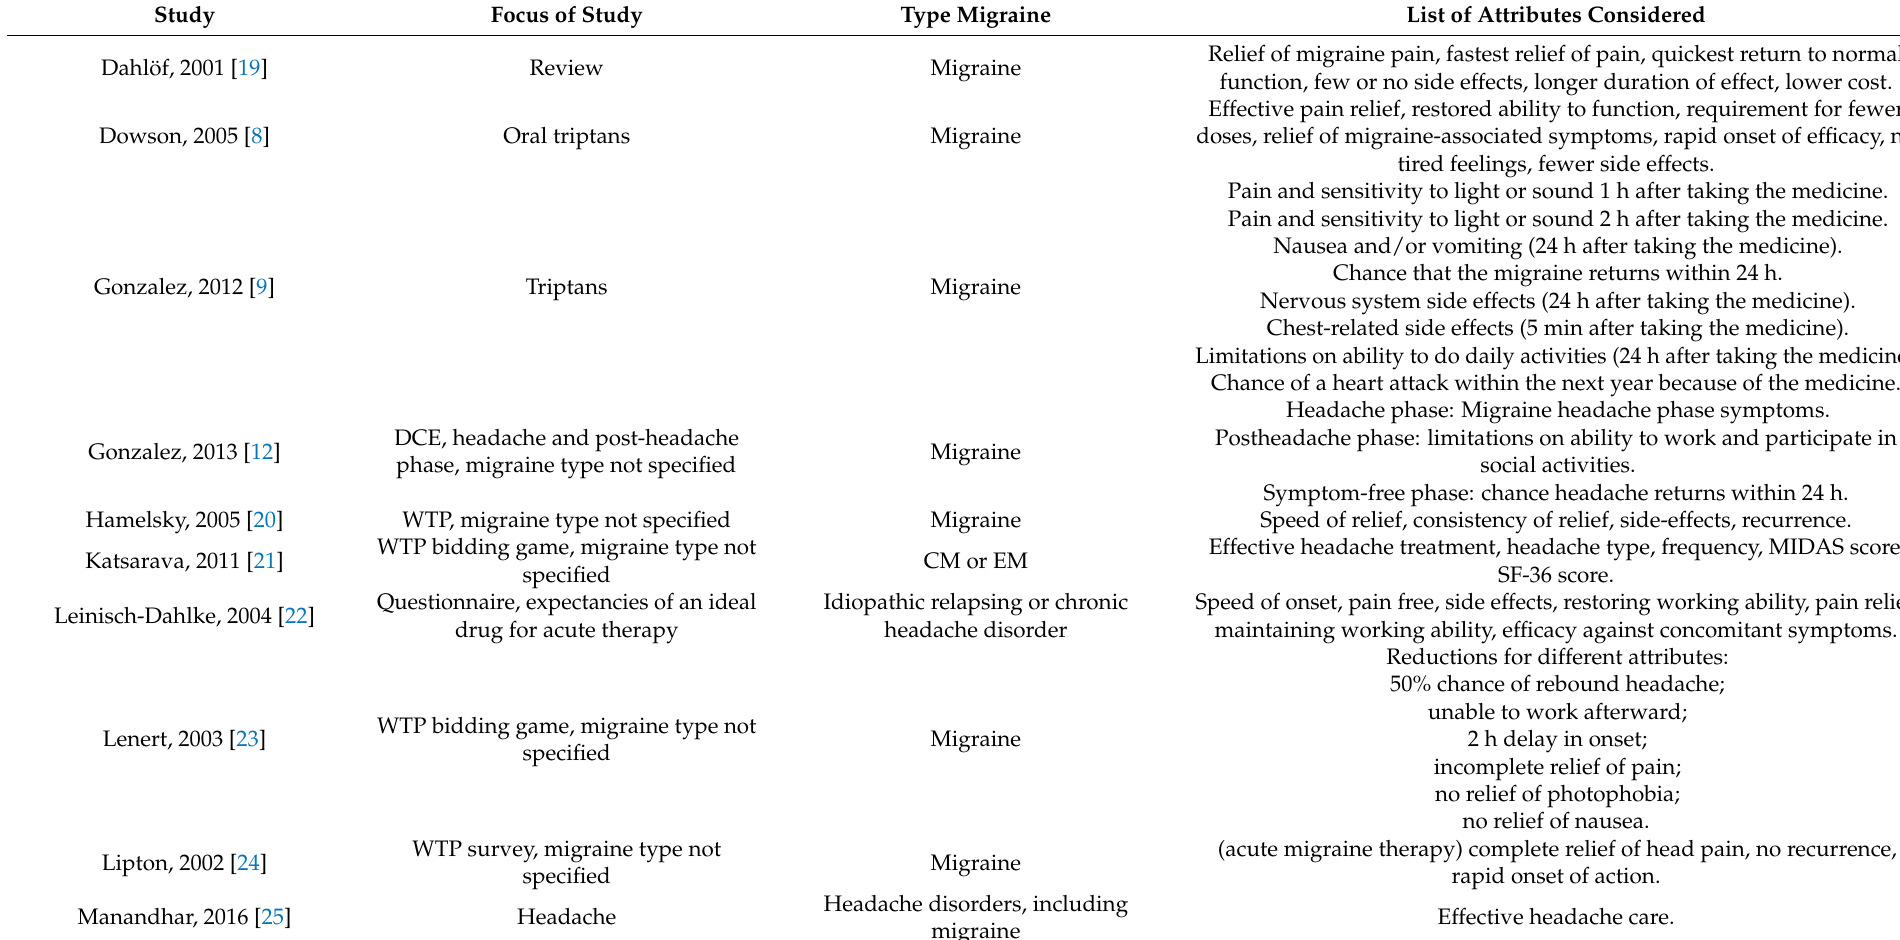
Table A1. Characteristics of the retrieved